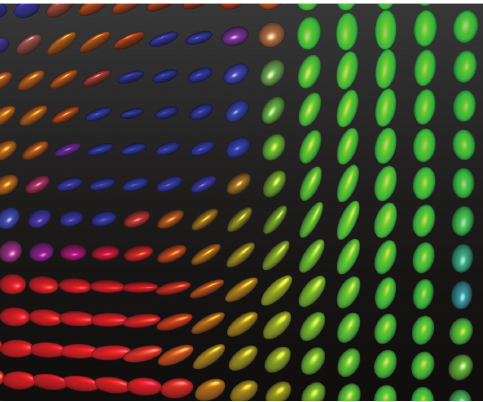
Figure 1: 3D glyphs visualizing di ff usion tensors. The orientation and sharpness of the glyphs depend on the eigenvectors and eigenvalues of the di ff usion tensor, respectively. In this image, the glyphs have been colored according to the orientation of the main eigenvector (e.g., a main eigenvector of (1,0,0) corresponds to a red glyph, while a main eigenvector of (0,0,1) corresponds to a blue glyph). This image was generated in the DTITool